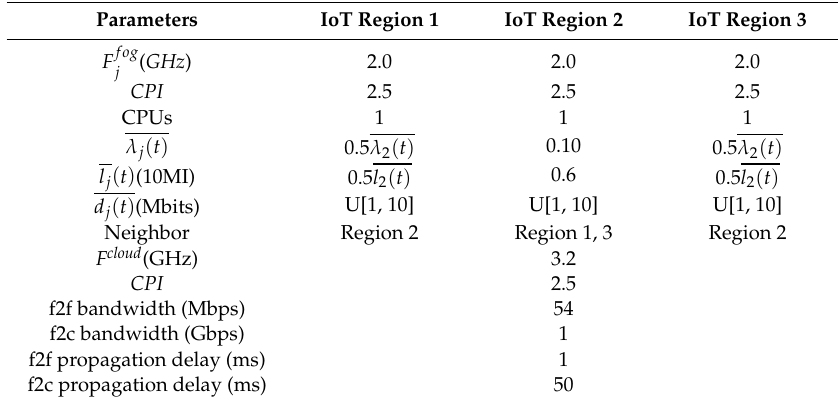
Table 1. The basic parameter settings.